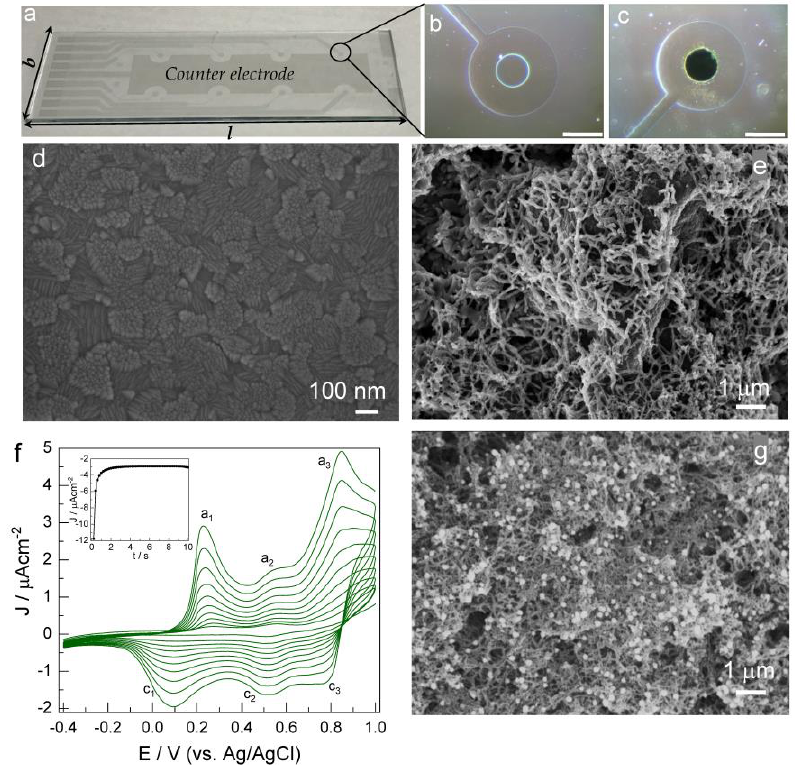
Figure 2. ( a ) Digital picture shows eight working indium tin oxide (ITO) disk electrodes along with large common counter electrode fabricated on glass substrates of dimension 7.5 × 2.5 cm ( l × b ), ( b , c ) optical images of bare ITO and Au-PANI coated ITO disk electrodes respectively. Scalebar is 500 μm. Scanning electron microscopy of ( d ) bare ITO; ( e ) PANI/ITO electrode; and ( g ) Au-PANI/ITO disk electrode surfaces respectively; ( f ) cyclic voltammogram obtained during potentiodynamic deposition of PANI on ITO electrodes at a sweep rate of 50 mV/s. The highest current peaks belong to the 10th (the last) cycle. The chronoamperometric curve represents the Au deposition process for a duration of 10 s shown in the inset of Figure 2f.